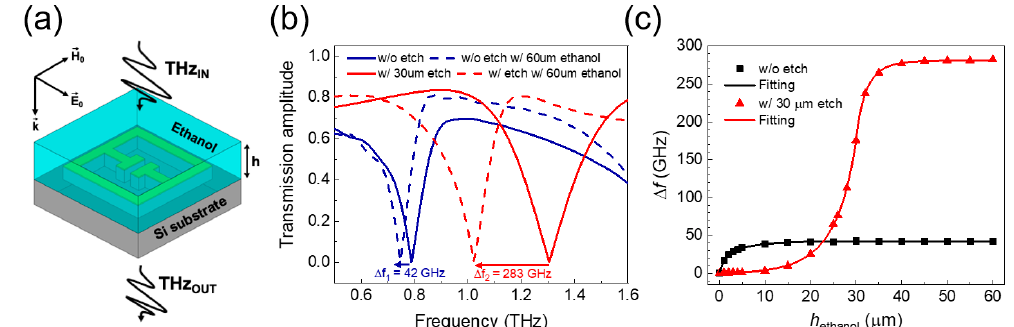
Figure 4. ( a ) Schematic of the THz metamaterial device with substrate etch for sensitive liquid sensing. ( b ) THz transmission of the metamaterials both with (red lines) and without (blue lines) an etch depth of 30 µ m, and both with (dashed lines) and without (solid lines) the presence of an ethanol liquid layer with a thickness of 60 µ m. ( c ) Resonant frequency shift as a function of h ethanol for the metamaterial liquid sensors with (red triangles) and without (black squares) an etch depth of 30 µ m.